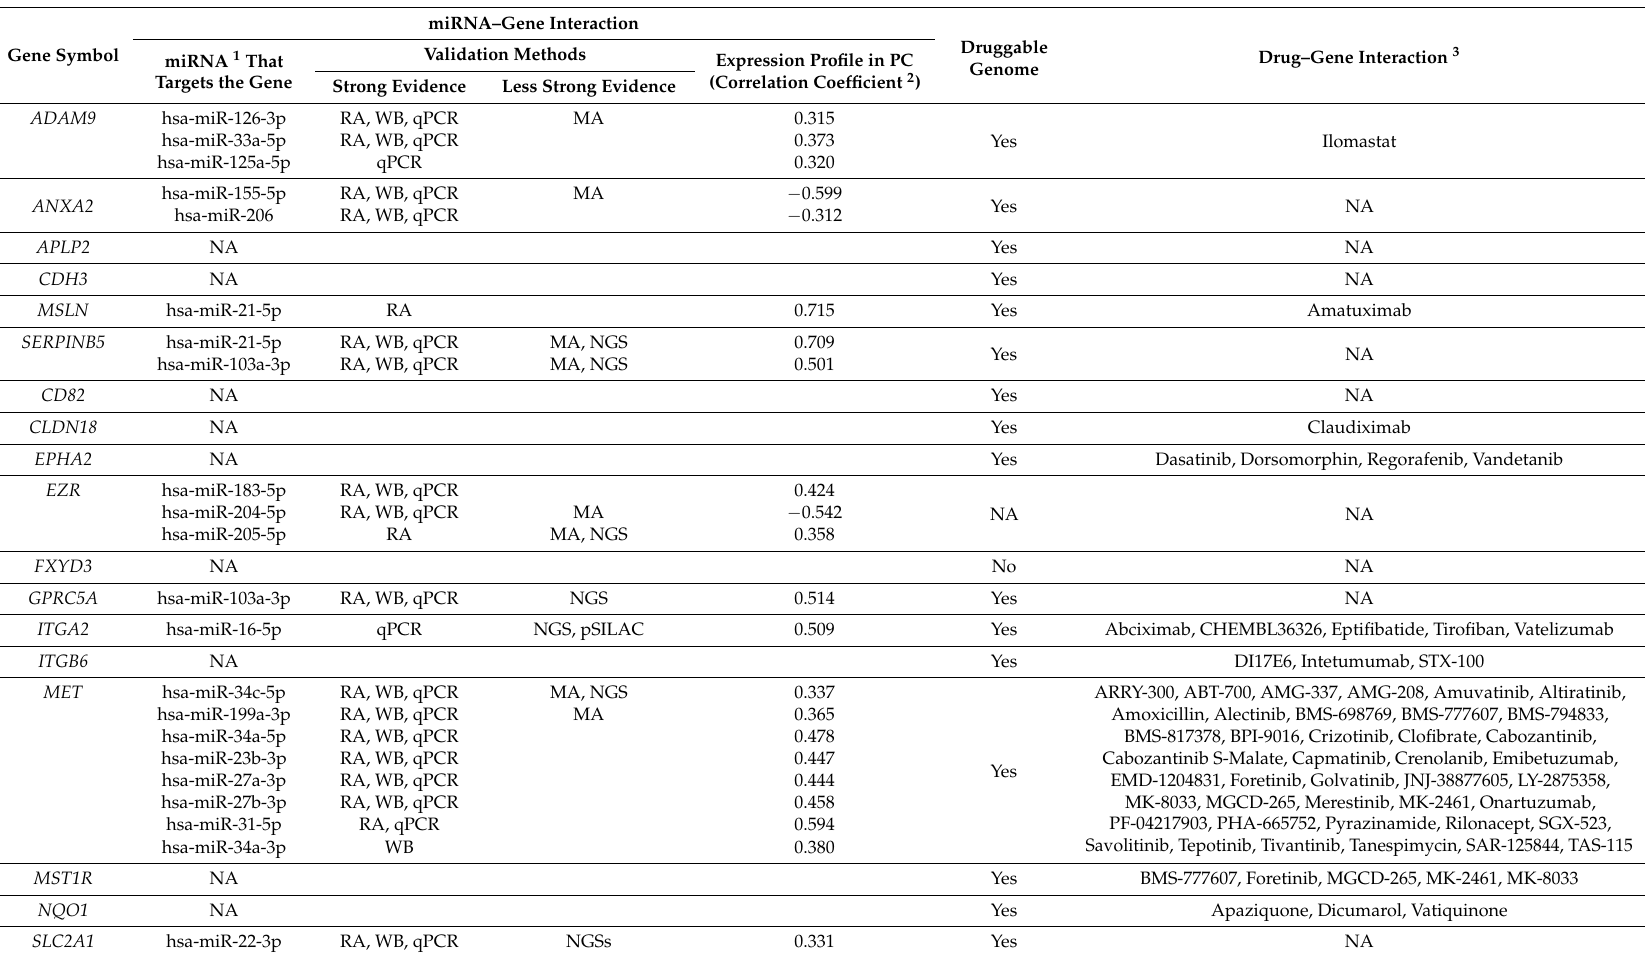
Table 3. Drug–gene and miRNA–gene interactions of 18 membrane